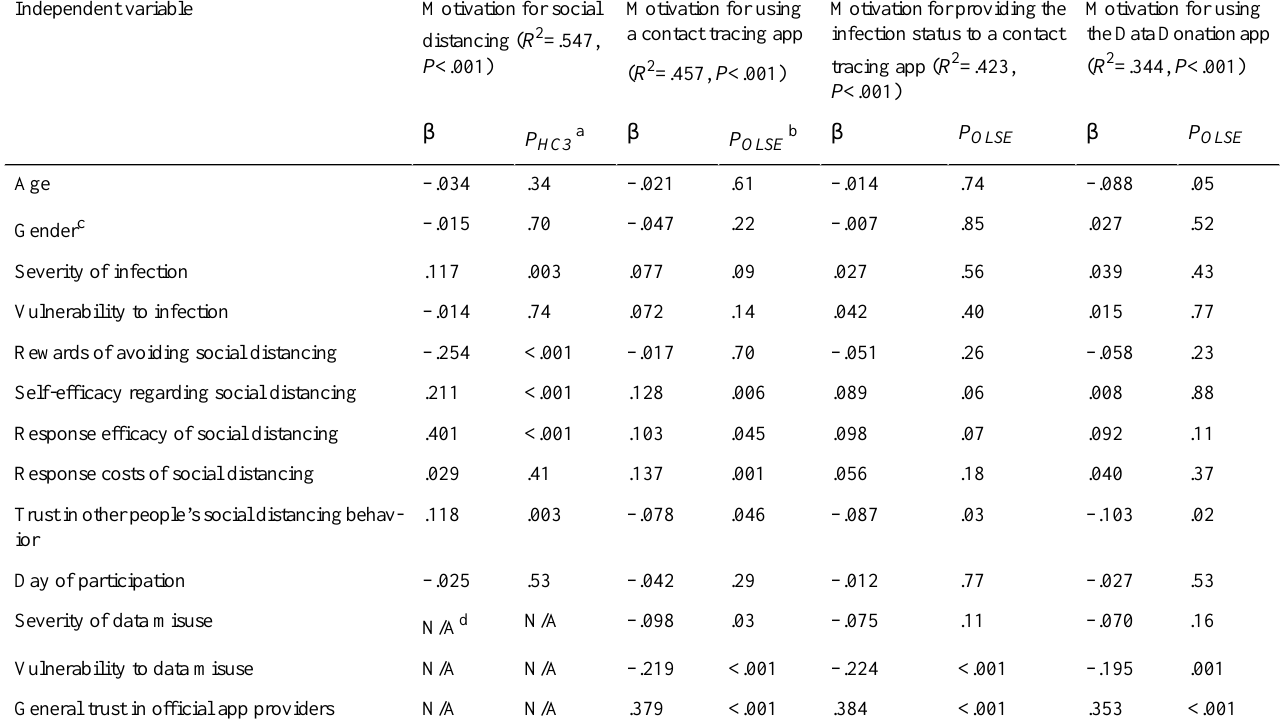
Table 3. Results of the multiple regression analyses with standardized coefficients ( β ) and P values based on the heteroscedasticity-robust HC3 estimator (P HC3 ) or standard OLS estimates (P OLSE